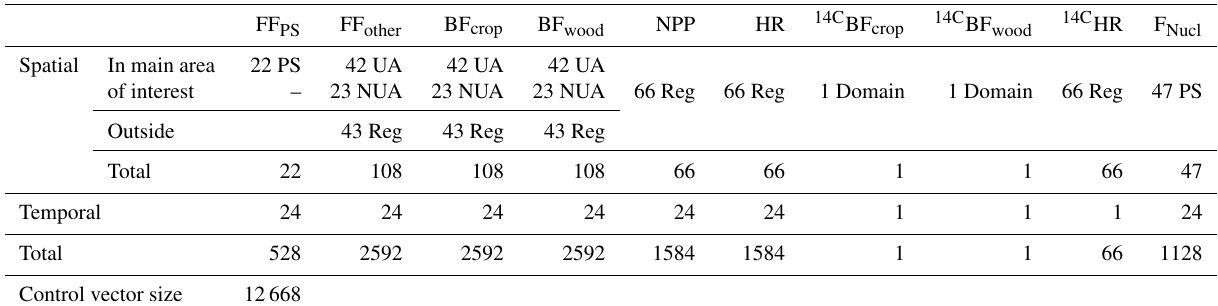
Table 2. Number of parameters in the control vector. The control vector is composed of scaling factors to be applied to budgets and maps of local and regional fluxes from the products presented in Sect. 2.3 (FF PS , FF other , BF crop , BF wood , NPP, HR, 14C BF crop , 14C BF wood , 14C HR, and Nucl). This table gives number and type of areas in the control vector: 66 administrative or coarser regions (Reg) defined in Fig. 5 and more detailed areas in the main area of interest. PS: point source emissions, UA: large urban area emissions, NUA: non-urban area i.e. the rest of the region when excluding the UA and domain: whole domain budget. In a 24h inversion window, 24 temporal parameters correspond to 1h temporal resolution and one parameter corresponds to daily resolution.